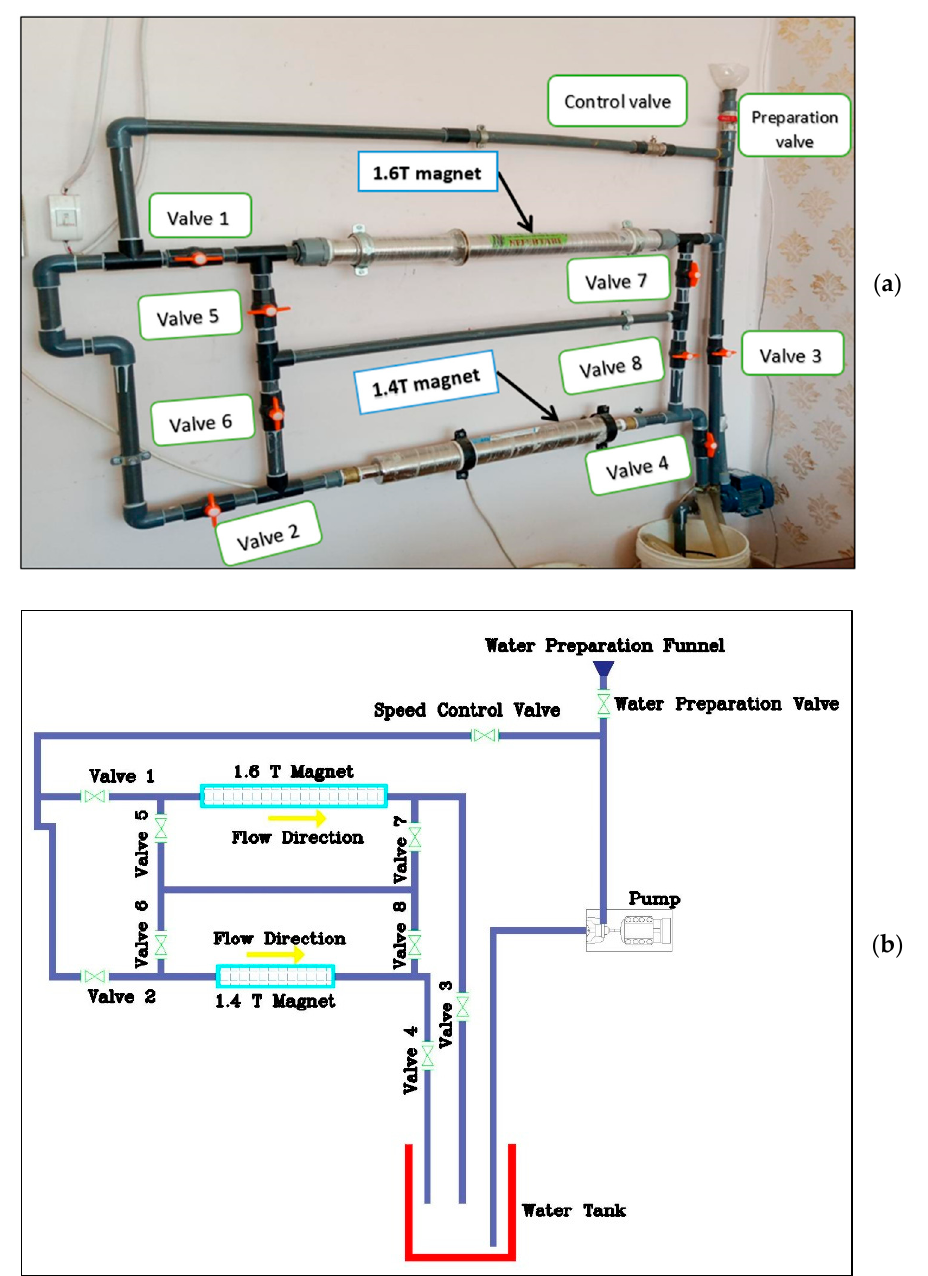
Figure 2. Water magnetization flow system: ( a ) real system, and ( b ) schematic drawing. Table 2. Details of the water magnetization methods used (10 L water).